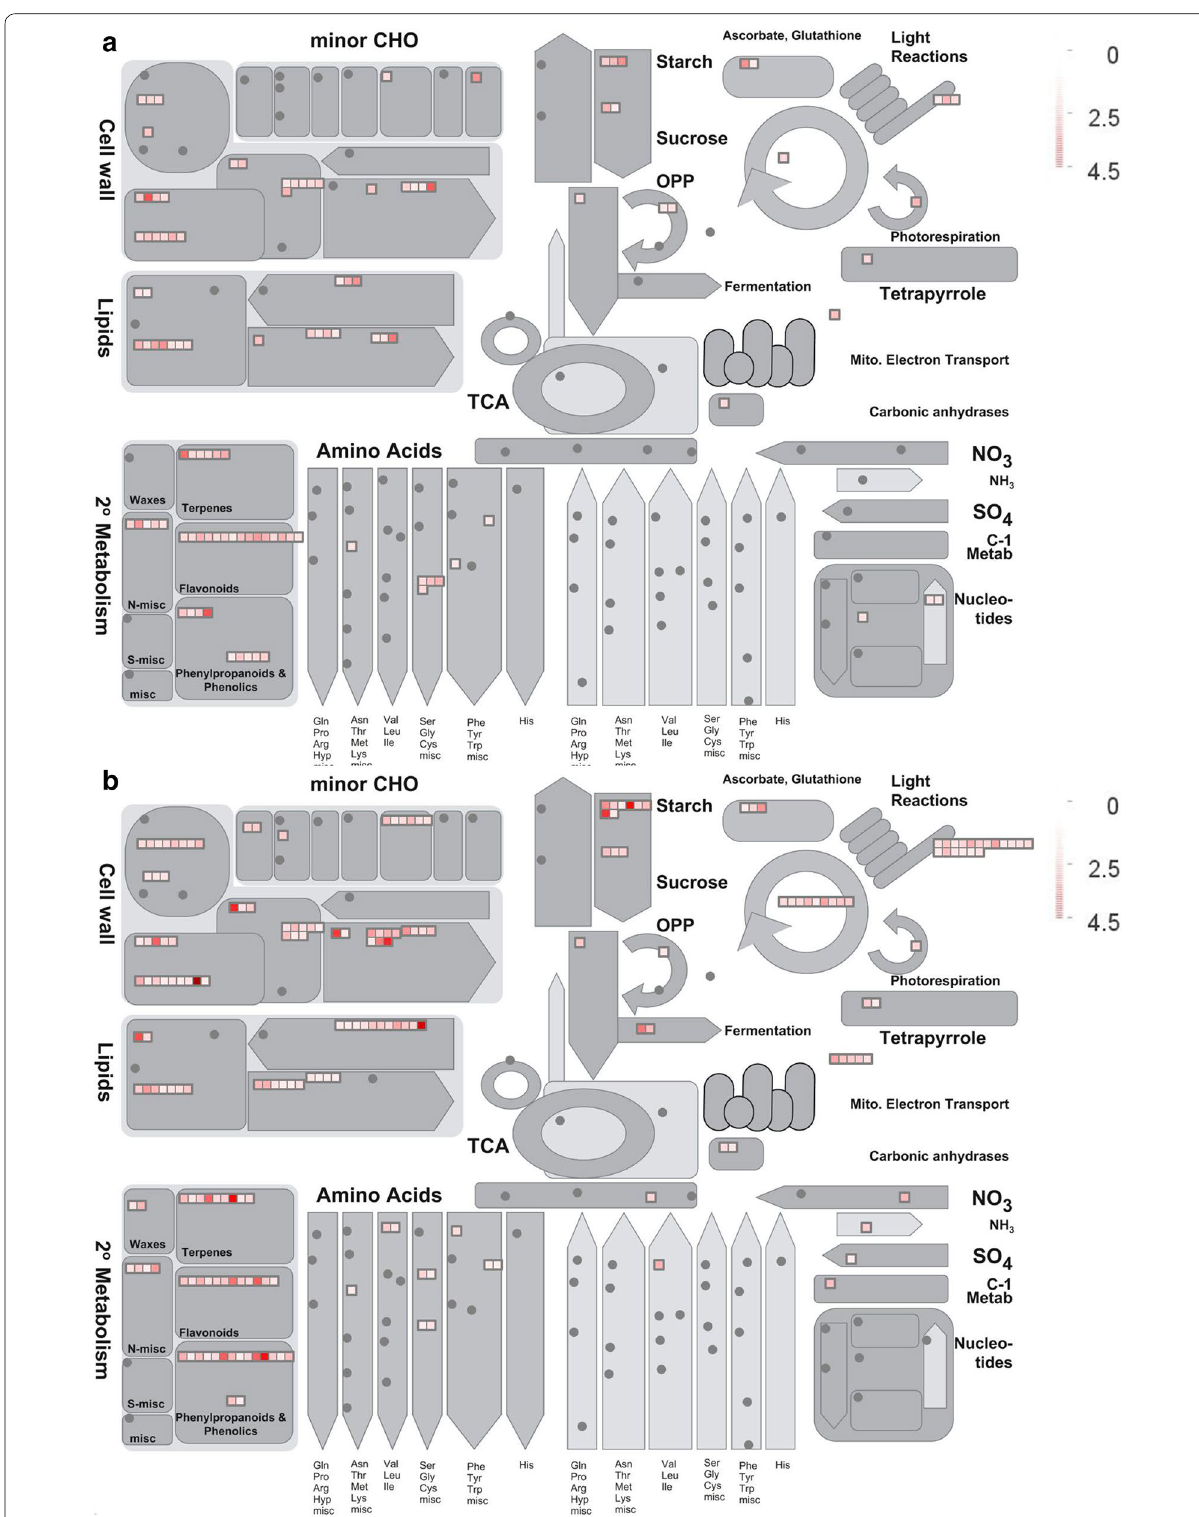
Fig. 7 MapMan analysis of fertile upregulation genes in different anther stages. Metabolism overview of MapMan analysis in fertile upregulated genes at a YM stage and b LpM